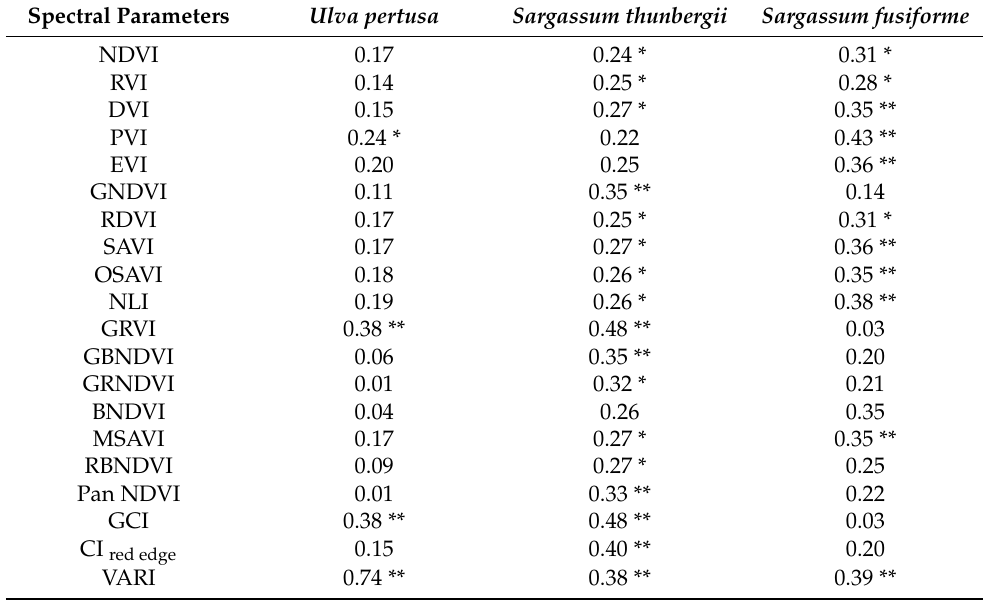
Table 2. Pearson’s correlation coefficients between original vegetation index and biomass. Spectral Parameters